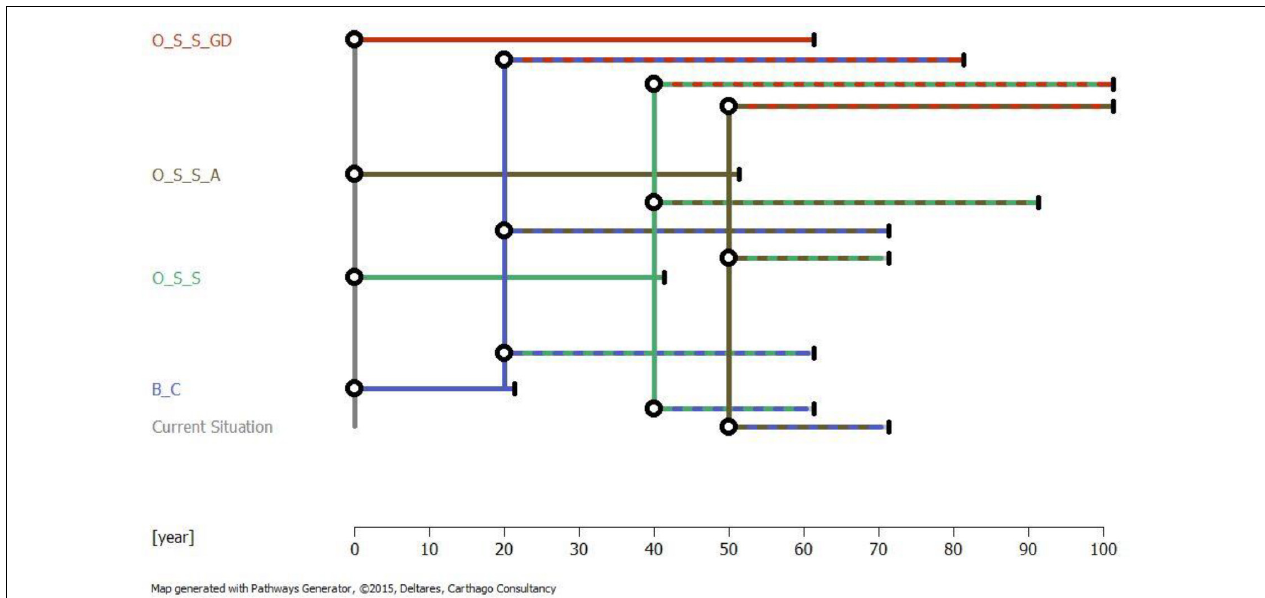
FIGURE 1 | Illustration of coastal adaptation pathways for a Mediterranean barrier beach subject to subsidence, because it is located in a deltaic system, and erosion due to longshore transport gradients in the sea (outer) side. This barrier beach has a limited natural sediment supply and experiences rotation due to frequent overwash and breaking processes, making the delineation of adaptation pathways extremely dynamic and complex. The selected pathways are: (B_C) Maintaining Breaching and Connectivity with a tipping point 20 years from now for an intermediate scenario, between RCP 2.6 and RCP 8.5; (O_S_S) Occasional Sand Supply for an intermediate scenario, with a tipping point 40 years from now; (O_S_S_A) Occasional Sand Supply and Sand Groins for the same intermediate scenario and with a tipping point 50 years from now; (O_S_S_GD) Occasional Sand Supply with Geo-Diversity for the same intermediate scenario and a tipping point 50 years from now. The circles denote change of pathway, moving to another type of approach/interventions. The vertical lines denote tipping points.